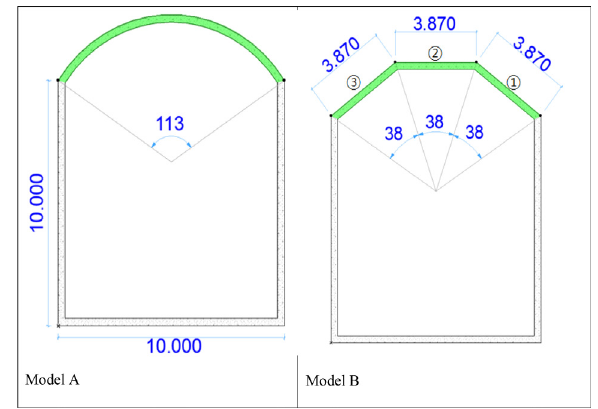
Fig. 11. Sample models